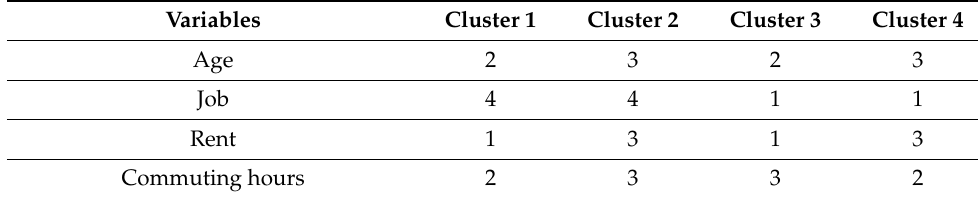
Table 5. Cluster center table (4 clusters).